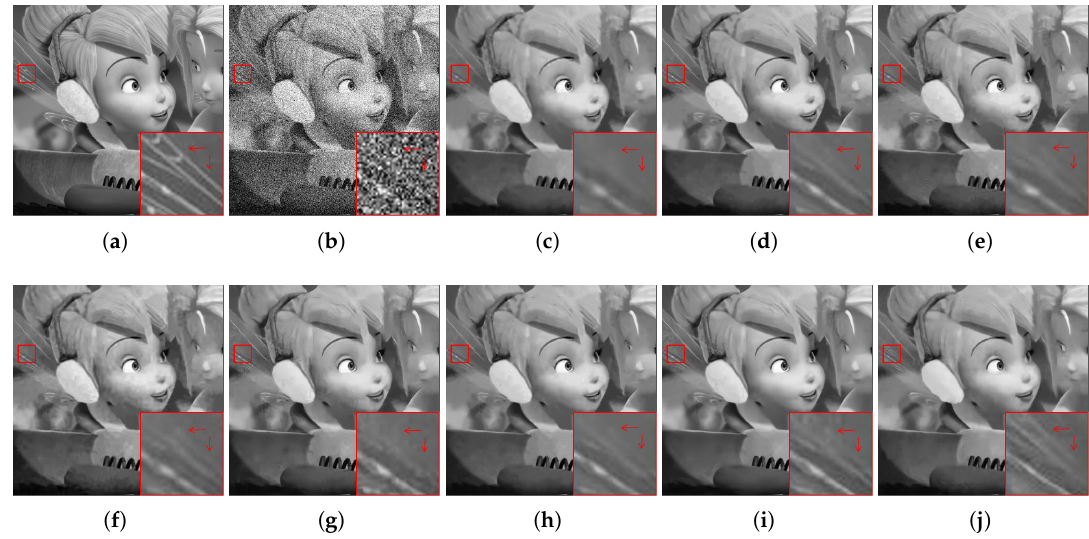
Figure 9. Comparison of denoising results of the competing methods for image selected from the ESPL synthetic image database with noise level σ = 50. ( a ) Original image. ( b ) Noisy image. ( c ) NCSR, PSNR = 29.21 dB. ( d ) WNNM, PSNR = 29.76 dB. ( e ) PGPD, PSNR = 29.56 dB. ( f ) BM3D, PSNR = 29.39 dB. ( g ) DnCNN, PSNR = 29.94 dB. ( h ) TWSC, PSNR = 29.59 dB. ( i ) FFDNet, PSNR = 30.32 dB. ( j ) Proposed, PSNR = 30.62